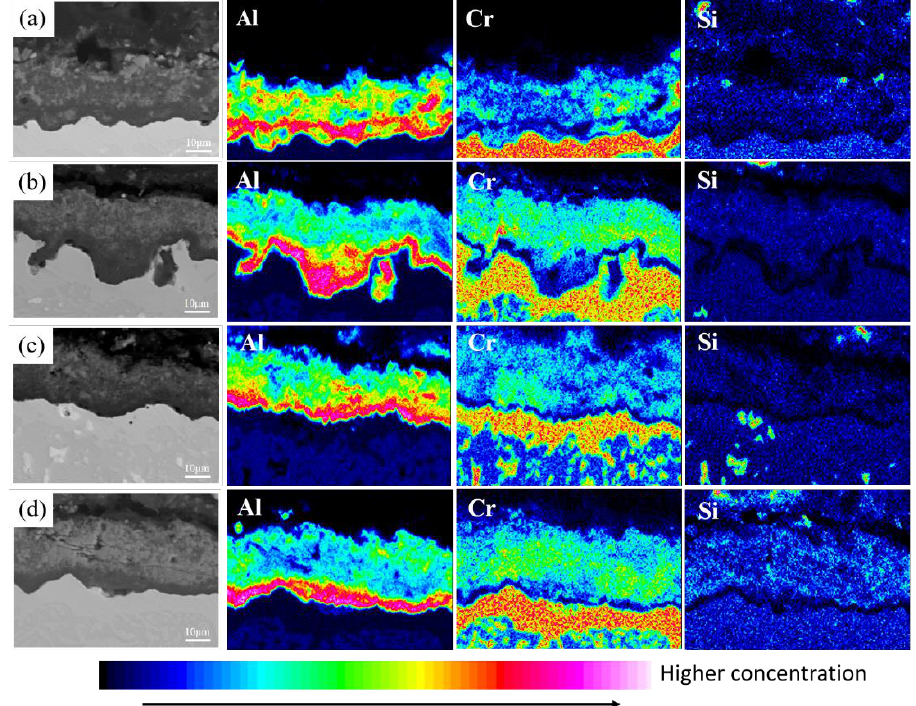
Figure 11. Element distribution of Al-Si coating at different pre-oxidation temperatures at 1000 °C constant temperature oxidation for 300 h: ( a ) untreated; ( b ) 900 °C; ( c ) 950 °C; ( d ) 1000 °C.